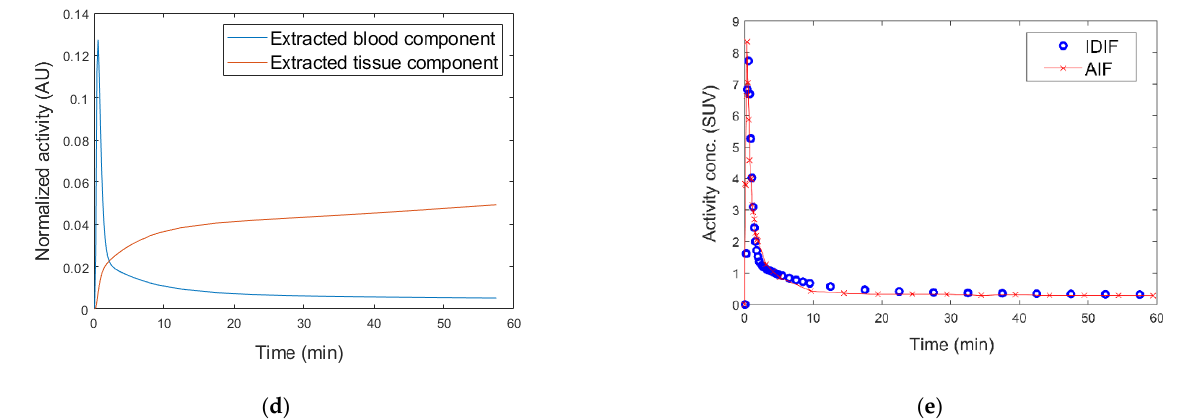
Figure 1. Demonstration of the IDIF extraction. ( a ) The coronal maximum intensity projection (MIP) of the summed early frames of the DPA-714 scan of one subject. ( b ) One axial slice of the neck area at the early frame. ( c ) The segmented regions (green contour) for carotid artery over the same slice. ( d ) The MBMF-extracted time-activity curves for the blood and tissue components. Note both curves are in the normalized and dimensionless form. ( e ) The resultant IDIF (blue circle) after the magnitude is re-scaled by the proposed method. The activities measured with arterial blood sampling are plotted as red stars, showing a satisfactory agreement between AIF and IDIF.